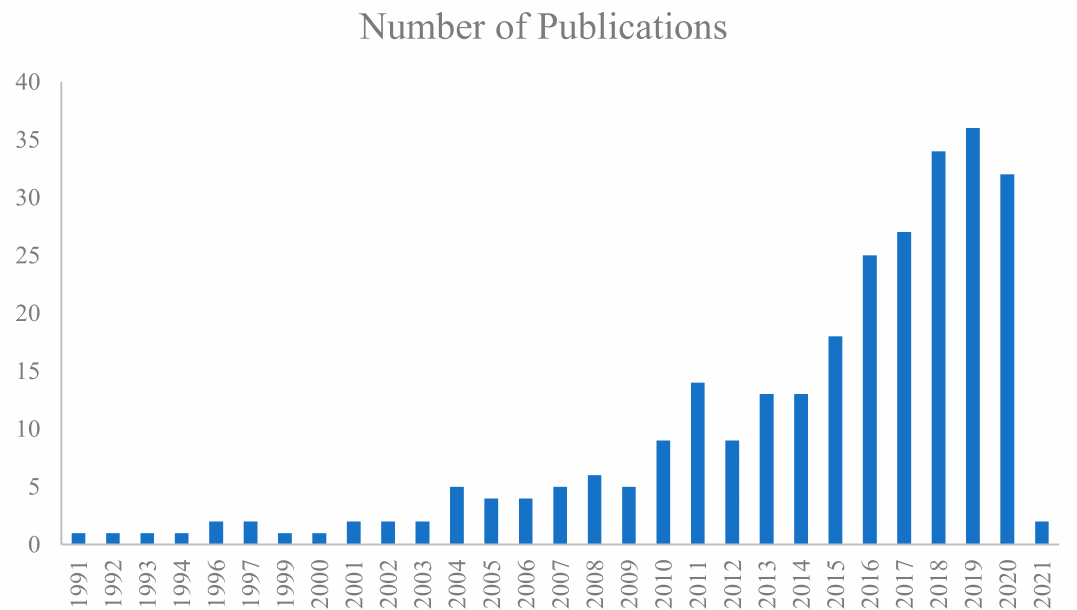
Figure 2. Number of published research articles searching the keywords “essential oils” and “delivery” and “pharmaceuti- cal”, source PubMed, last update 12 January